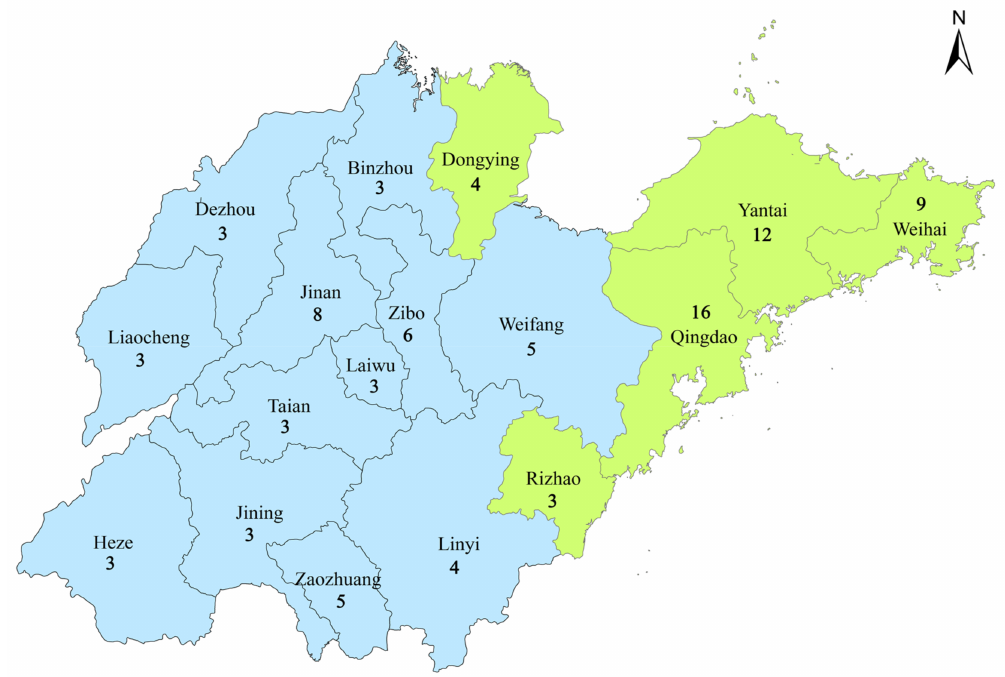
Figure 1. The locations of the 17 cities in the Shandong Province; the coastal cities are shown in the green color. The numbers represent the count of air quality monitoring stations in each